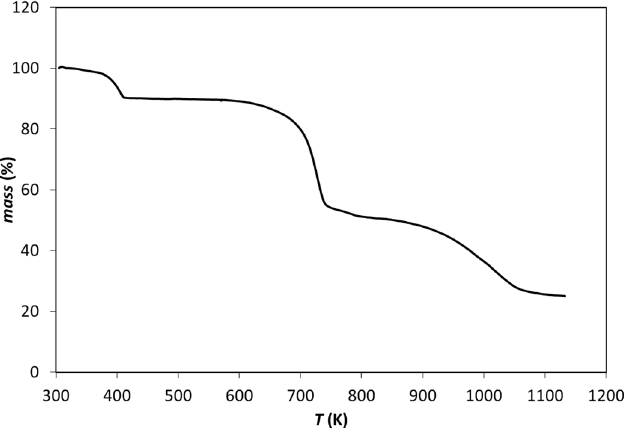
Figure 3. TGA results for Zn(dcpa) as a function of temperature (heating rate of 3 K/min). The Zn(dcpa) porosity was evaluated by N 2 adsorption at 77 K. The obtained isotherm is plotted in Figure 4, showing an initial step followed by a smoother increase until p / p 0 = 0.06; then, another steep increase is observed before reaching a nearly constant plateau with only a small increase between p / p 0 = 0.2 (274 cm 3 /g) and p / p 0 = 0.97 (303 cm 3 /g). Note that p and p 0 are the equilibrium and saturation pressures of the adsorbate at 77 K, respectively. The same behavior was observed by Liu et al. [34] who attributed the first step of the isotherm to the Zn(dcpa) structure with shrunken pores, and the second step to an expanded structure. In our work, the expanded structure had a specific pore volume of 0.47 cm 3 /g, determined at a relative pressure of p / p 0 = 0.97, assuming the pores were filled with condensed liquid N 2 at its normal boiling point. The desorption branch showed hysteresis at p / p 0 < 0.2, which is also in accordance with a previous report, although in our case, the hysteresis loop seemed to close at